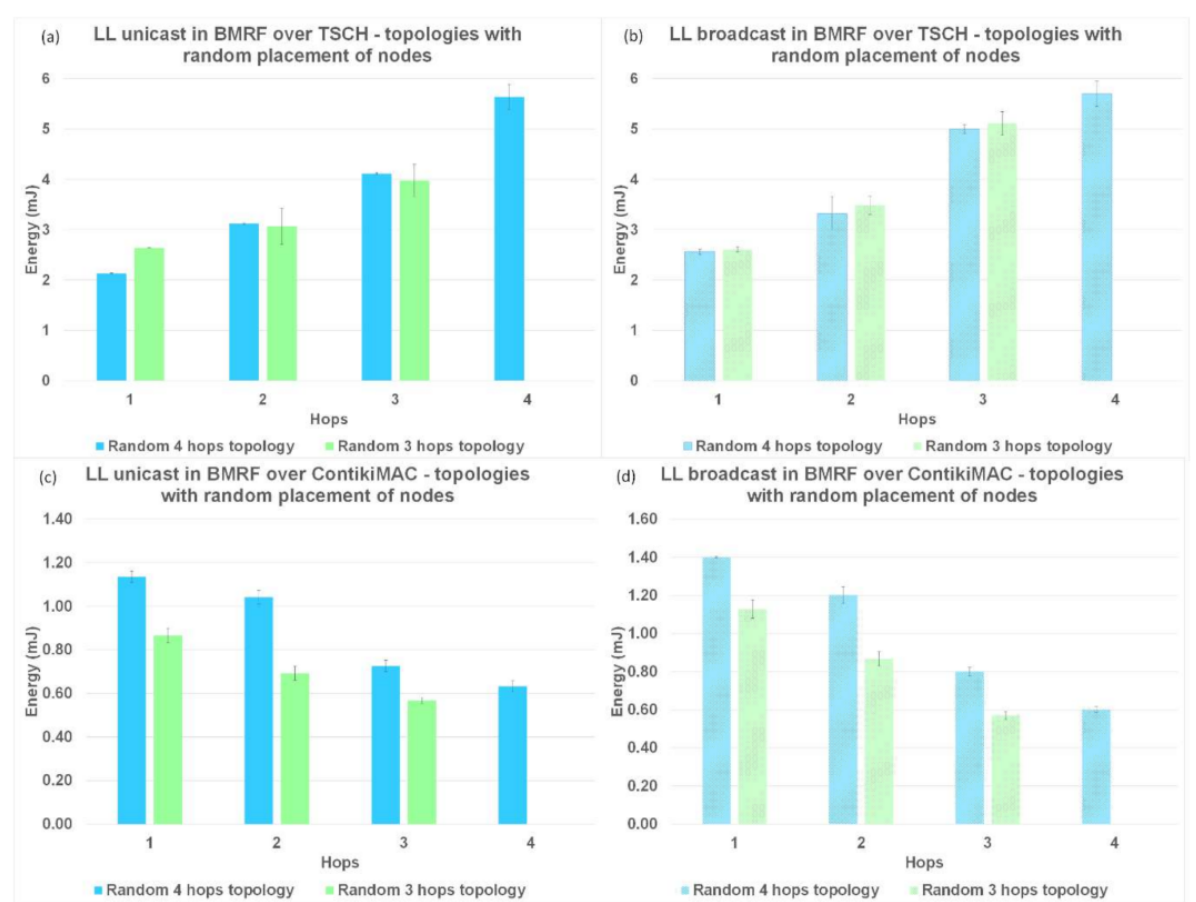
Figure 17. Energy comparison between LL unicast and LL broadcast and between ContikiMAC and TSCH on topologies with a random placement of nodes. ( a ) Results for LL unicast in BMRF over TSCH. ( b ) Results for LL broadcast in BMRF over TSCH. ( c ) Results for LL unicast in BMRF over ContikiMAC. ( d ) Results for LL broadcast in BMRF over